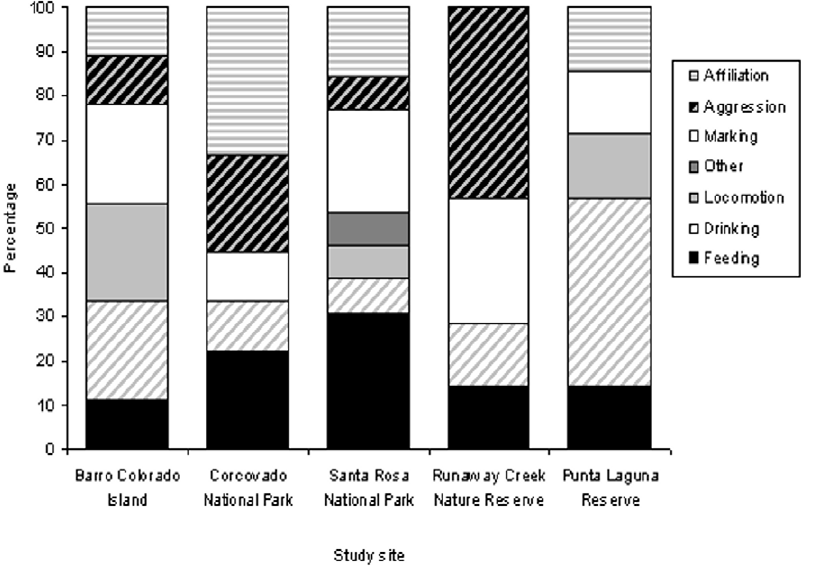
Figure 3. Percentage of behaviors showing evidence of tradition at each site by sub-domain category. See Table S1 for the division of behaviors into sub-domains and Figure 1 for the traditions at each site. Note that the only behavior in the sub-domain ‘Other’ was wind catching at the Santa Rosa site.